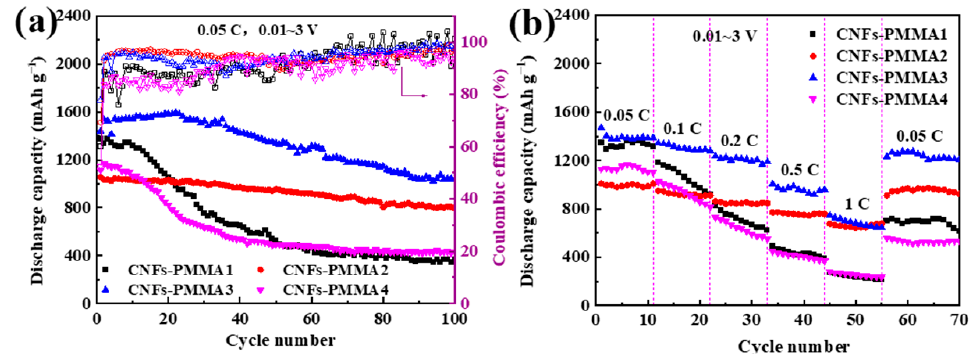
Figure 3. ( a ) Cycle performance and ( b ) rate performance curves of CNFs-PMMA1, CNFs-PMMA2, CNFs-PMMA3, and CNFs-PMMA4 anodes in lithium-ion batteries. After determining the amount of PMMA, the effect of the silicon content on the hierarchical porous carbon nanofiber anode is further studied. The microscopic morphologies of CNFs-Si0%, CNFs-Si5%, CNFs-Si10% and CNFs-Si15% materials are shown in Figure 4a–d. These carbon nanofibers have a good fiber shape with a diameter of about 1 µ m, which are randomly intertwined to form a fiber cloth. With the increase in the Si content from CNFs-Si0%, CNFs-Si5%, CNFs-Si10% to CNFs-Si15%, the white particles increase, due to the agglomeration of nano silicon particles. The SEM image of CNFs-Si10% and the corresponding EDS mapping of elements are shown in Figure 4e. Some holes exist in distributed, indicating that Si and N are effectively doped in nanofibers. It is worth noting not discussed further in this work.